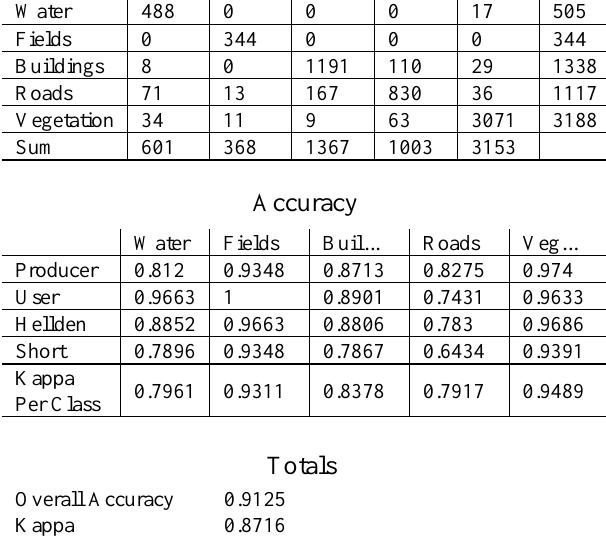
Table 5. Confusion matrix, accuracy and totals combining high vegetation classes with cultivated fields / low